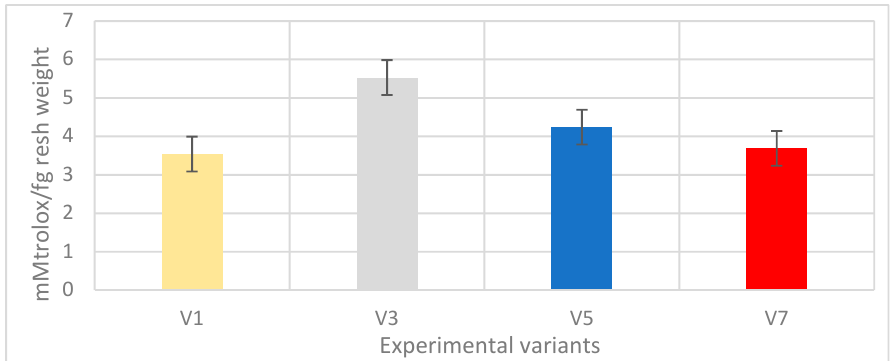
Figure 5. The antioxidant activity in Lepidium sativum L. sprouts on gauze substrate (V1 control, illuminated with sunlight; V3, illuminated with white LED; V5, illuminated with blue LED; and V7, illuminated with red LED experimental variants). Data acquired from the experiment were statistically investigated and are expressed as the mean ± SD (standard deviation). Bars are one standard deviation.